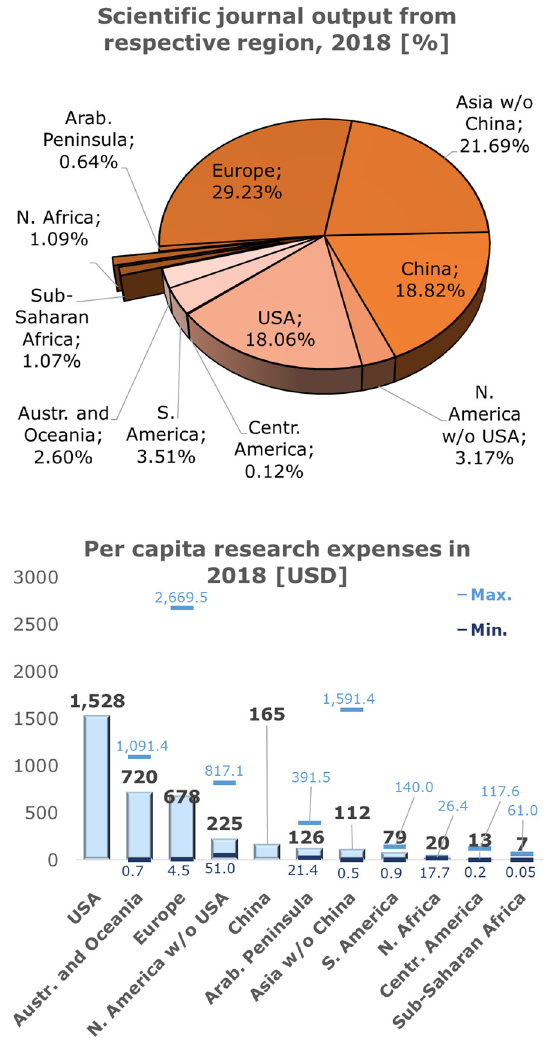
Figure 2. Scientific and technical journal output indexed in SCI/SSCI from different regions in the world (a) (data source: [13]), and per capita research expenses in these regions (b) (data sources: [12,